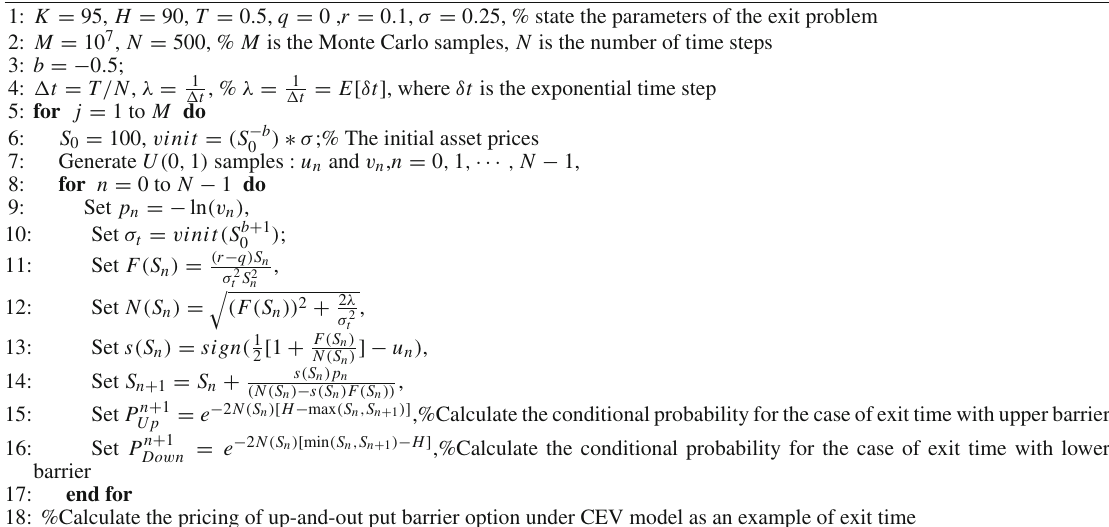
Algorithm 1 The improved Exp algorithm for the exit time